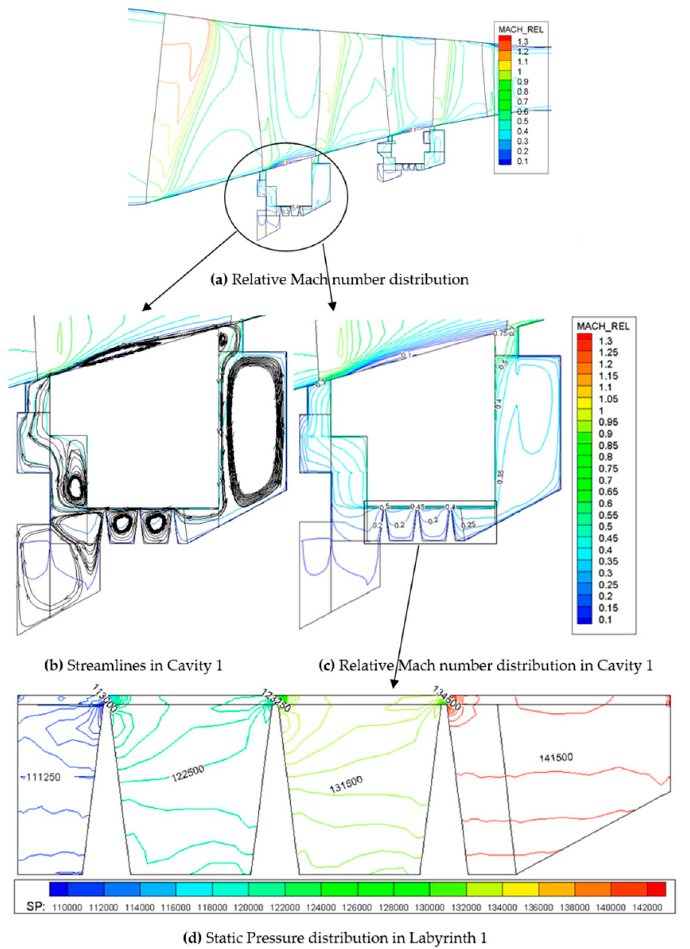
Figure 8. Flow field at near-stall point of configuration